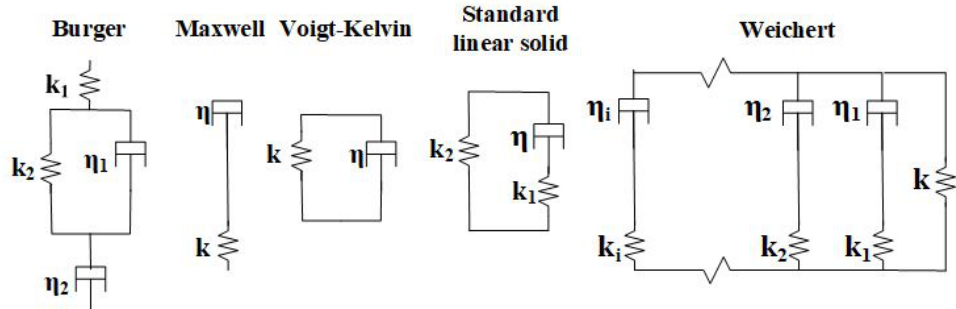
Figure 1. Basic rheological models. k is the stiffness of the spring and η the viscosity of the dash-pot, representing the linear and viscous parts of the material,